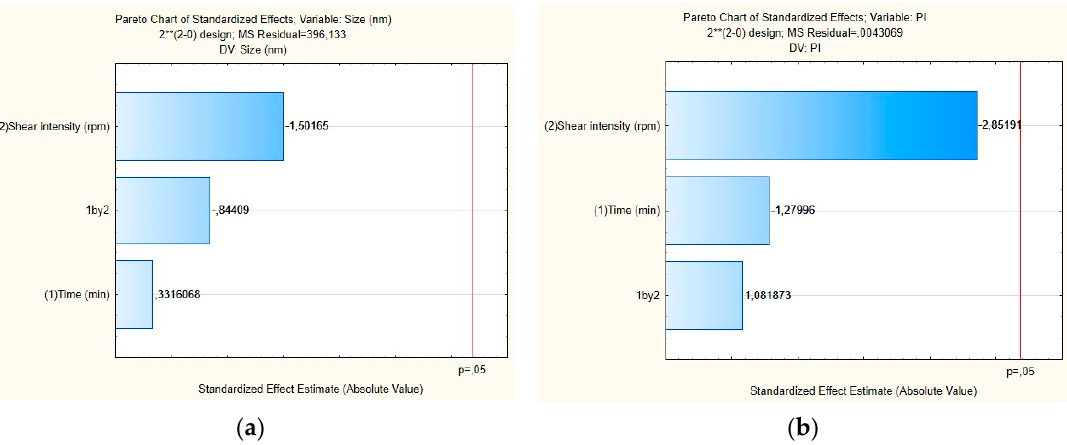
Figure 4. Pareto charts of the standardized effects for RSV-loaded NLC obtained for ( a ) particle size (Z-average) and ( b ) polydispersity index (PDI).